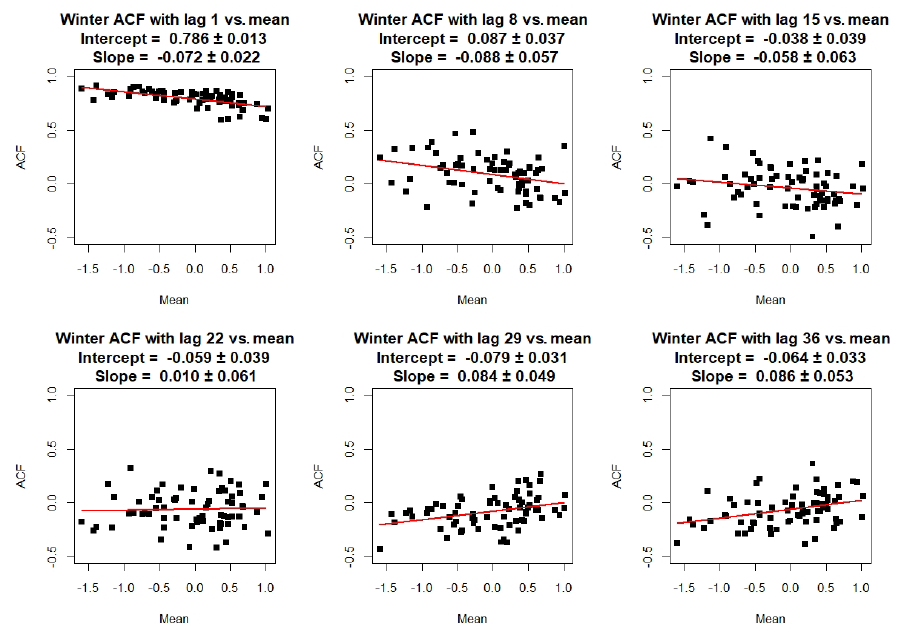
Figure 3. Relation between sample ACF of the daily NAO winter index and the sample mean for 71 winters. The plots show the sample ACF for lags 1, 8, 15, 22, 29, and 36, respectively. The red lines are fitted regression lines. Point estimates and 95% confidence intervals for the intercepts and slopes of these lines are given above each plot.